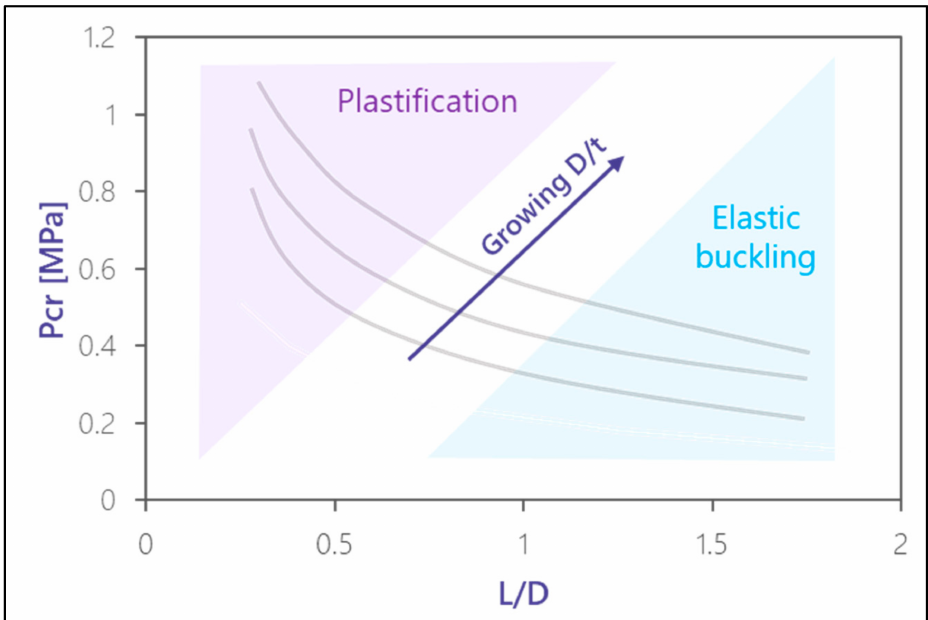
Figure 16. Failure modes for liners with either stiffeners or